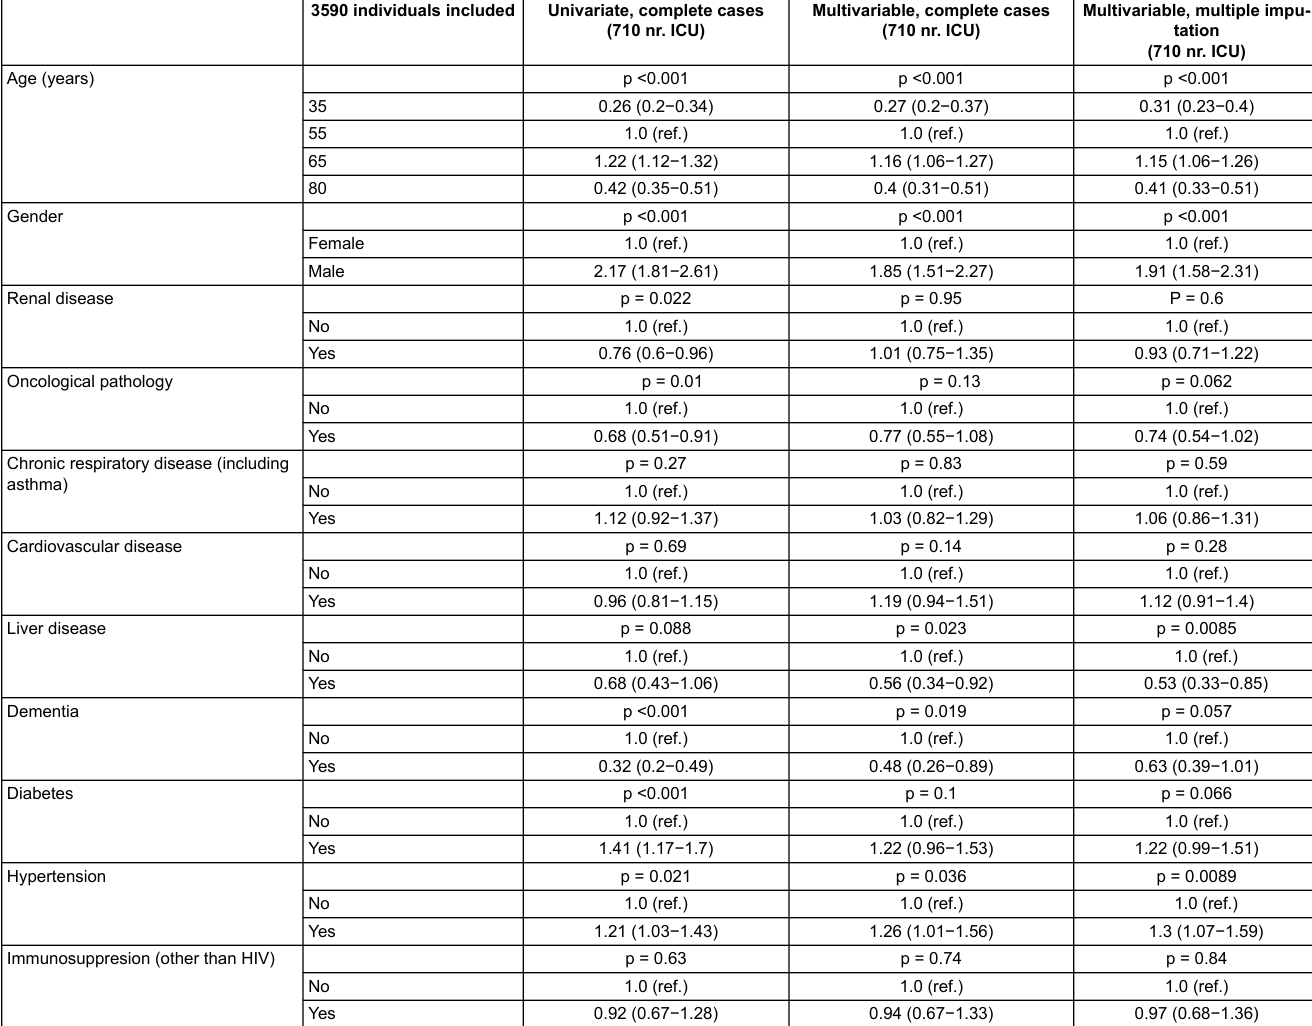
Table 4: Odds ratios (95%CI) for ICU admission in hospitalised COVID-19 patients (n = 3590) in Swiss